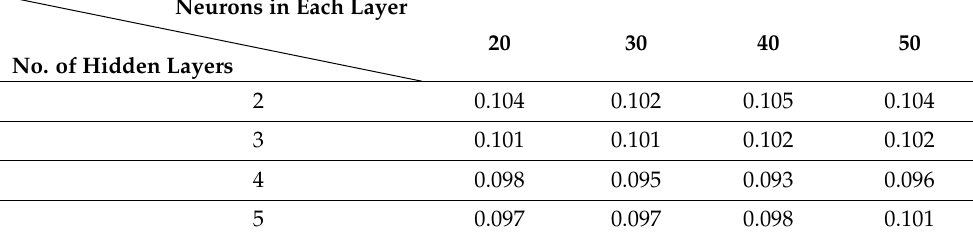
Table 3. Root mean square error of validation data sets for neural network grid search.